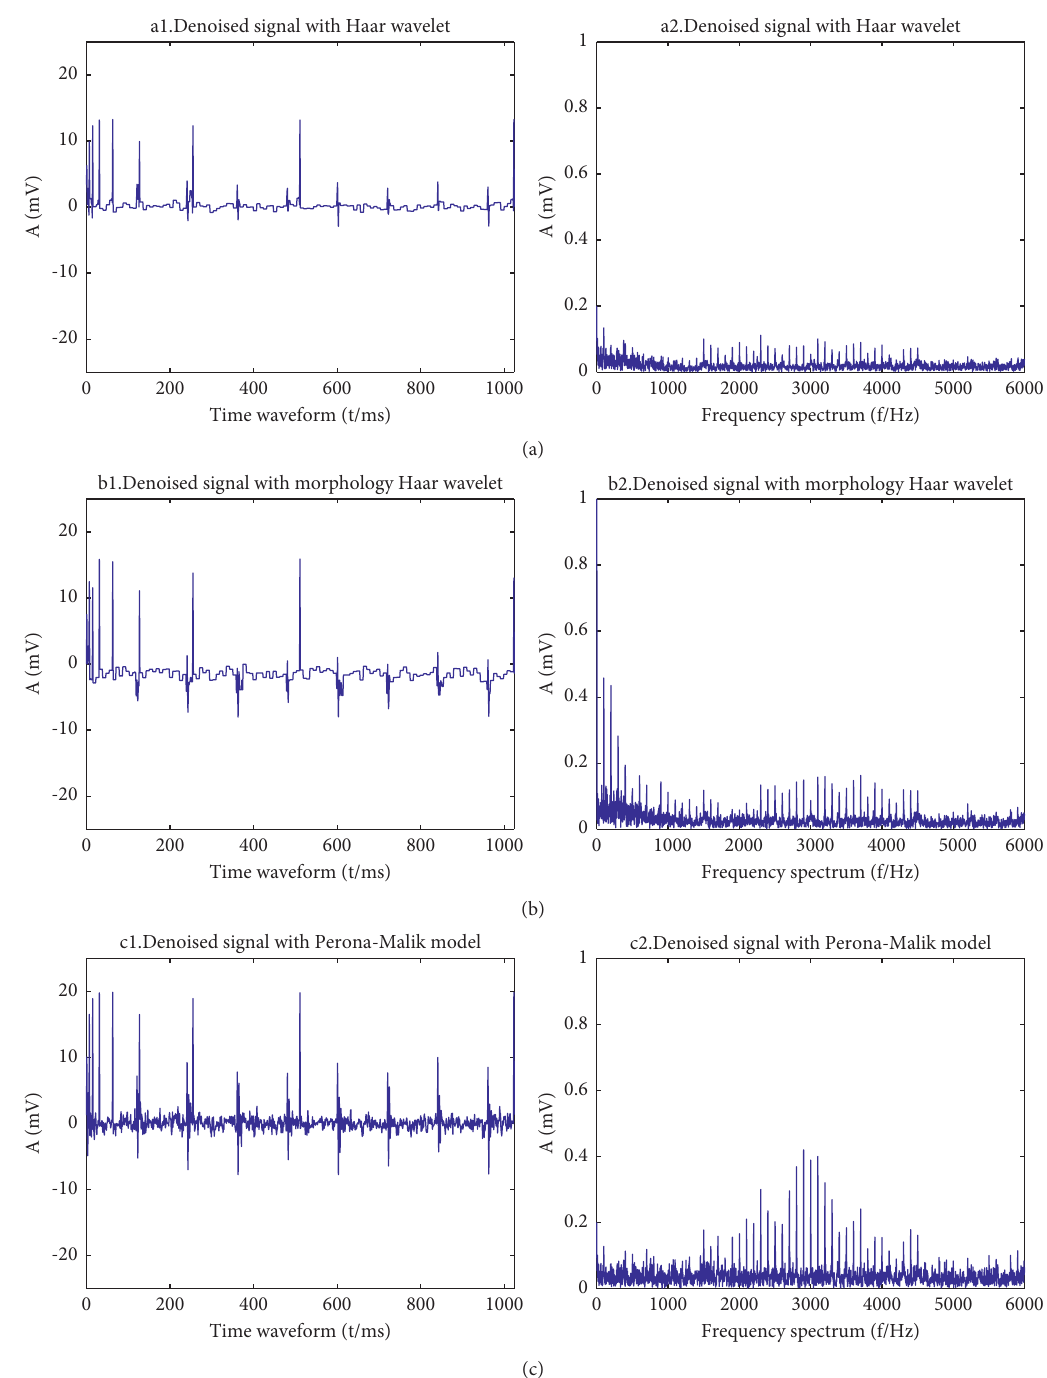
Figure 2: Comparison between PDE model and other denoising algorithms. (a) Denoised signal with Haar wavelet. (b) Denoised signal with morphology Haar wavelet. (c) Denoised signal with the Perona–Malik